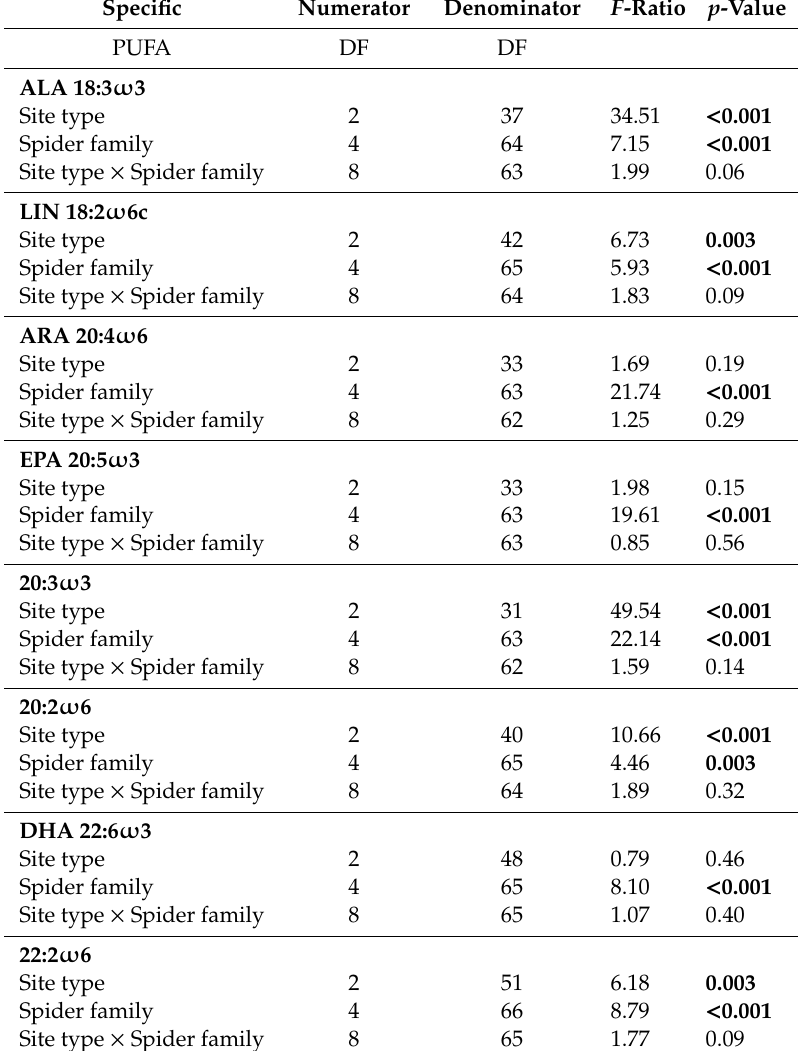
Table 2. Mixed-e ff ects models ANOVA testing the main e ff ects site type, spider family and their interaction on the content of the eight specific